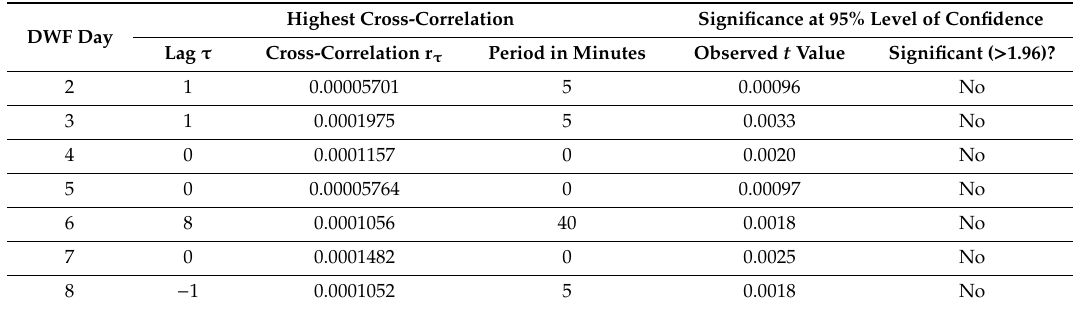
Table 1. Summary of highest cross-correlations with DWF Day 1 data and the